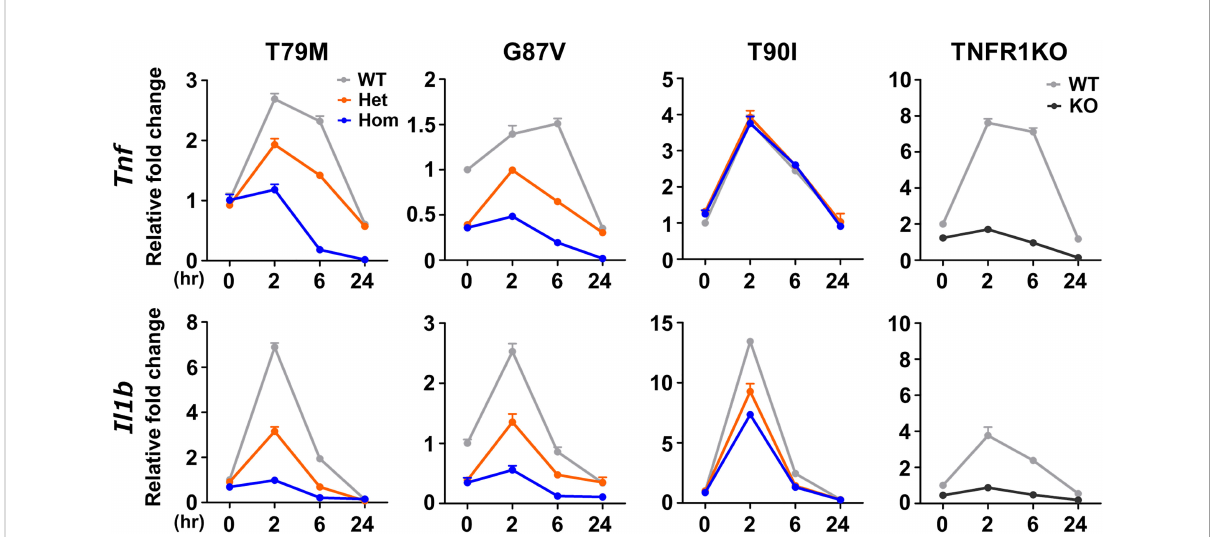
FIGURE 5 Decreased responsiveness to TNF a in the TRAPS mutations. Primary murine bone marrow-derived macrophages were stimulated with 100 ng/ mL TNF a . RNA samples were collected at indicated time points. Cell culture experiments were performed separately for each strain. The mRNA expression levels of Tnf and Il1b were determined using qPCR. The WT levels at 0 h were set to 1. Gray, orange, blue, and dark gray lines indicate WT, heterozygous, homozygous, and TNFR1KO mice, respectively. TNF a , Tumor necrosis factor a ; TRAPS, TNF receptor-associated periodic syndrome; WT, wild-type; Het, heterozygote; Hom,